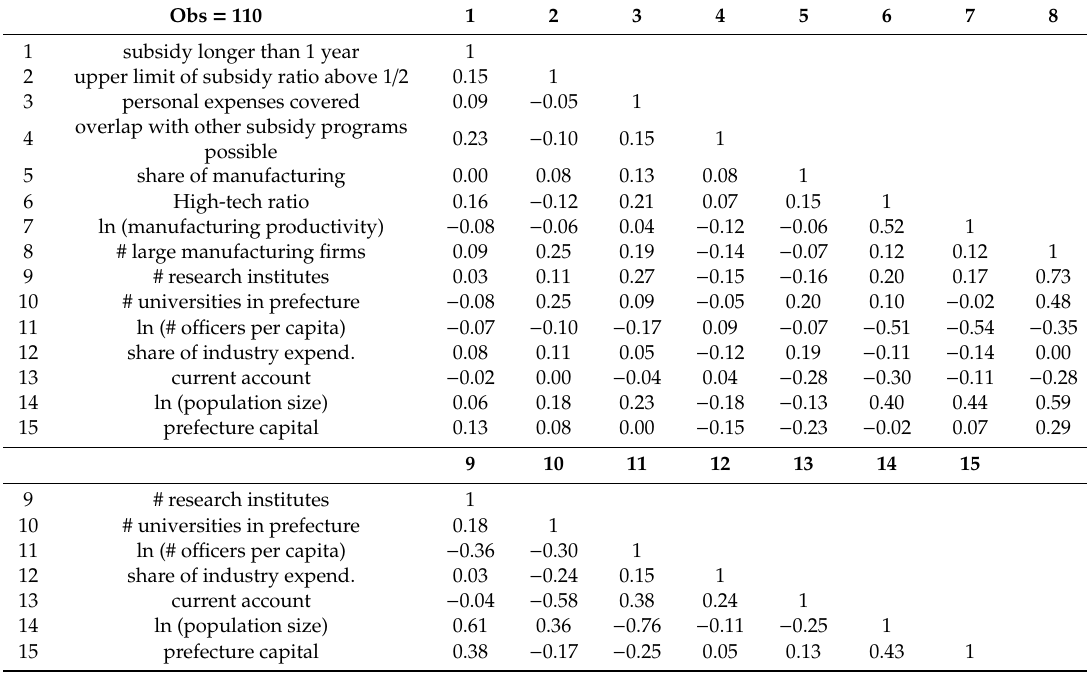
Table 5. Correlation matrix of variables used in the second empirical